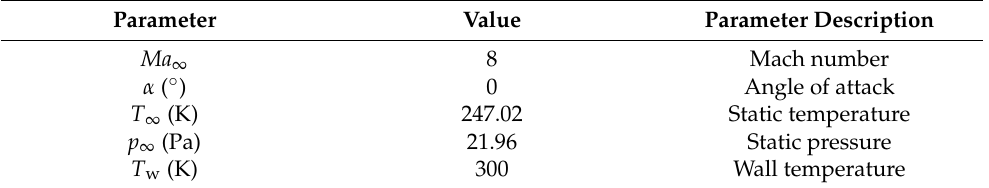
Table 4. Parameters of hypersonic flow and wall temperature.